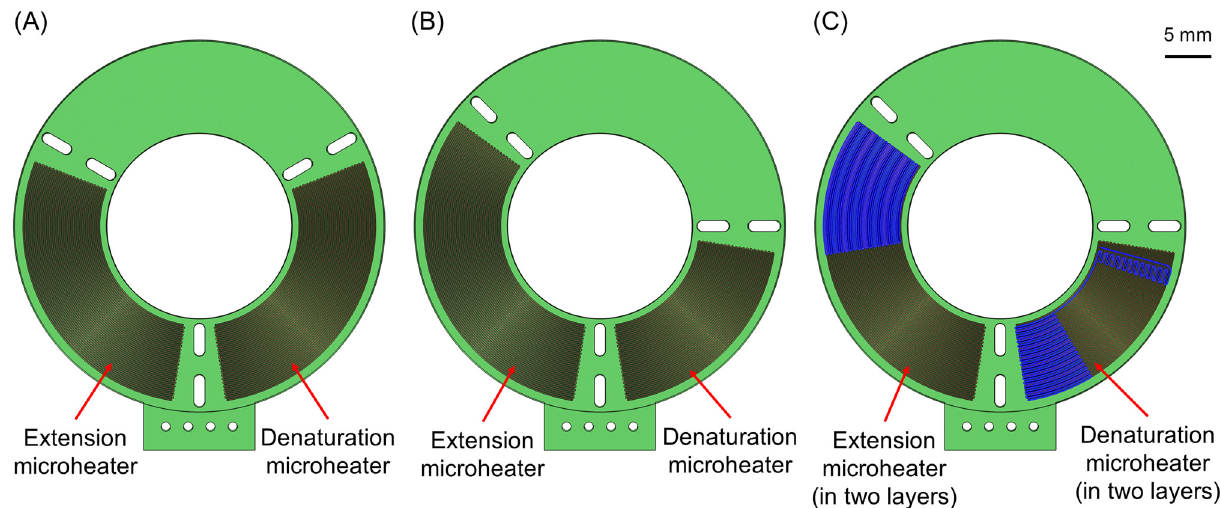
Figure 3. The three different microreactor geometries. ( A ) First microreactor geometry, with the temperature zone areas evenly distributed on the surface of the chip. ( B ) Second microreactor geometry, with the denaturation zone reduced in favor of the other two temperature zones. ( C ) Third microreactor geometry, with the ratio of the temperature zones as in the second geometry but with the microheaters designed in two different copper layers inside the PCB.